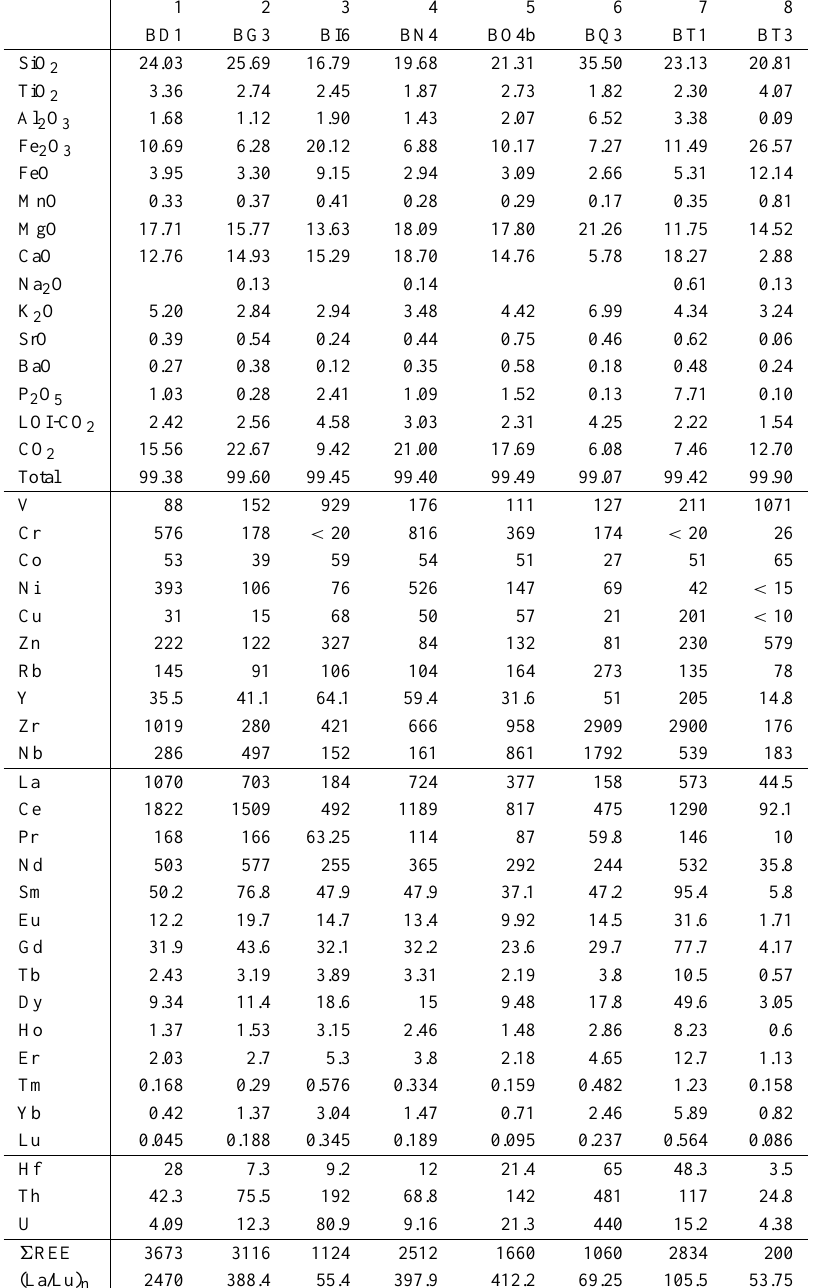
Representative bulk-chemical analyses of Araxá mica-rich rocks (1-12, G; 13-20, MOP; 21-24, MC). For rock abbreviations see Table I. Major and trace elements in wt% and ppm,